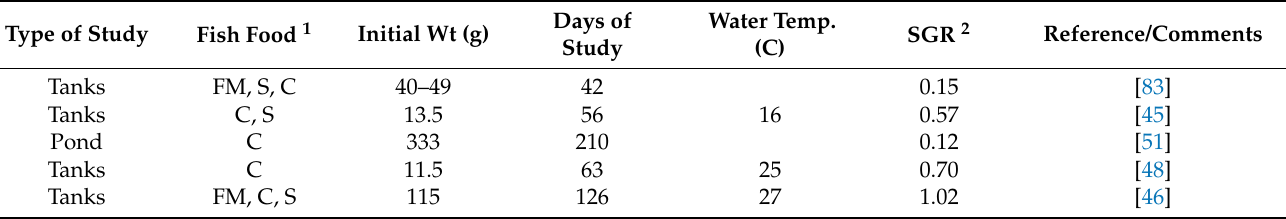
Table 8. Specific growth rates (SGR) of carp in this study compared to other